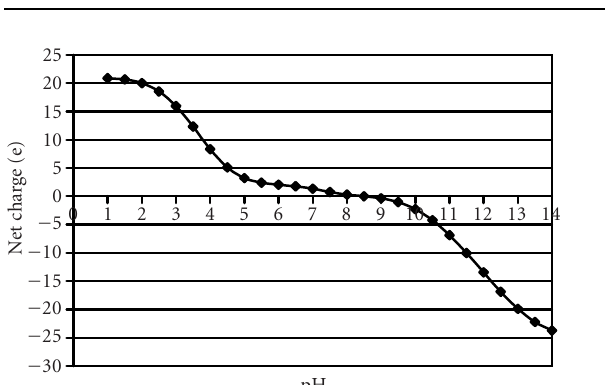
Figure 5: Titration curve of cutinase predicted by TITRA Plot of net charge of cutinase versus pH, calculated at a step width of 0 . 5 pH units.